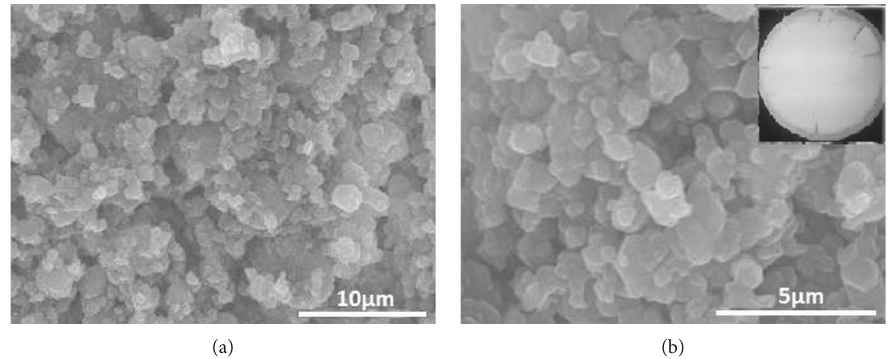
Figure 1: SEM images of silicone rubber/TiO 2 without the surfactant Triton X-100. (a) Low magnification; (b) high magnification.